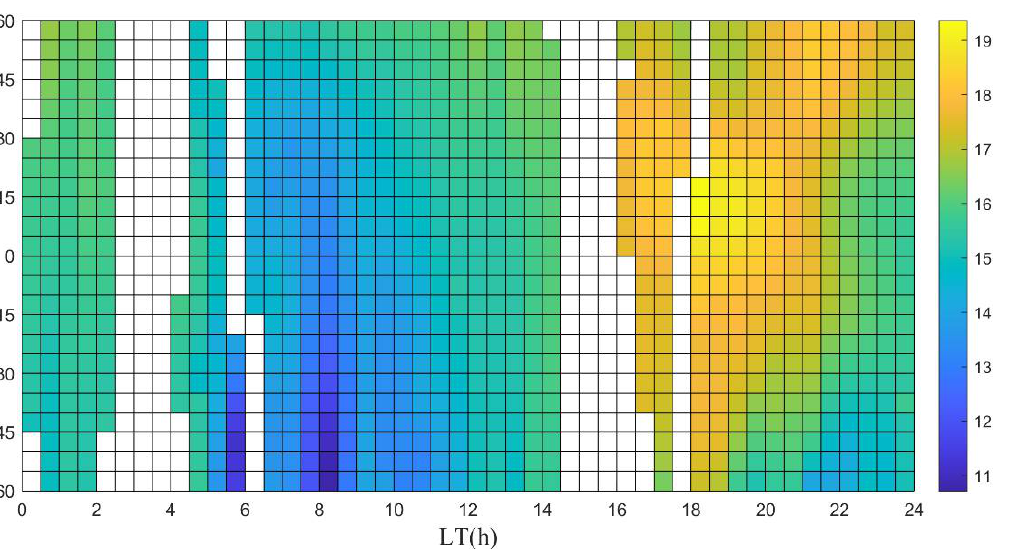
Figure 7. The diurnal variation of mean molecular mass m s (g/mol) from 15 April 2014 to 11 August 2014 (The same calculation as Figure 4).